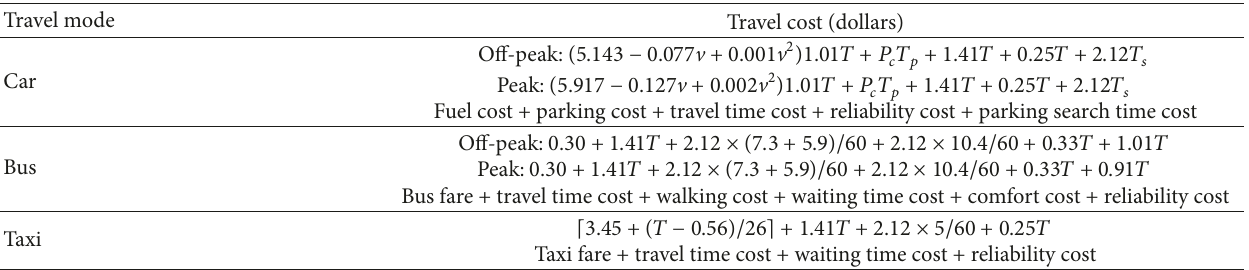
Table 1: Travel cost of all types of travel mode.